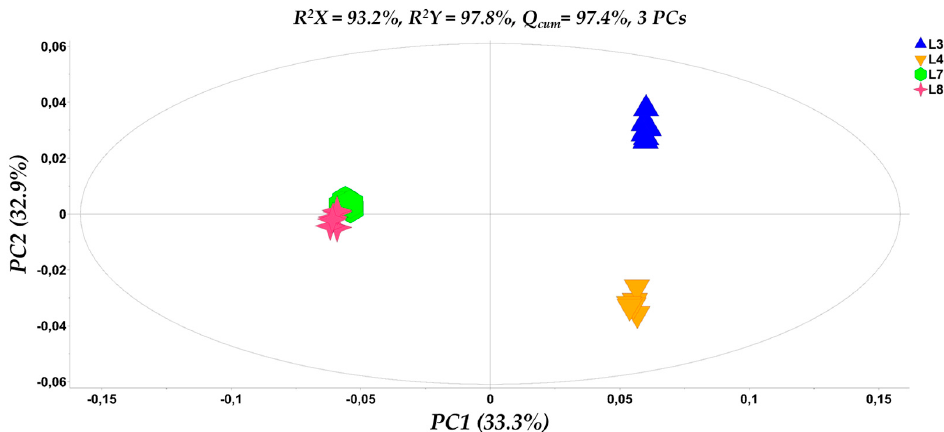
Figure 3. Orthogonal partial least squares discriminant analysis (OPLS-DA) PC1/PC2 score plot for the analyzed GC/EI/MS metabolite profiles of Lupinus albus cultivars. The ellipse represents the Hotelling’s T 2 [R 2 X and R 2 Y; fraction of the sum of squares of X’s and Y’s explained by the components, Q 2 (cum) ; cumulative fraction of the total X’s variation that can be predicted, PC; principal